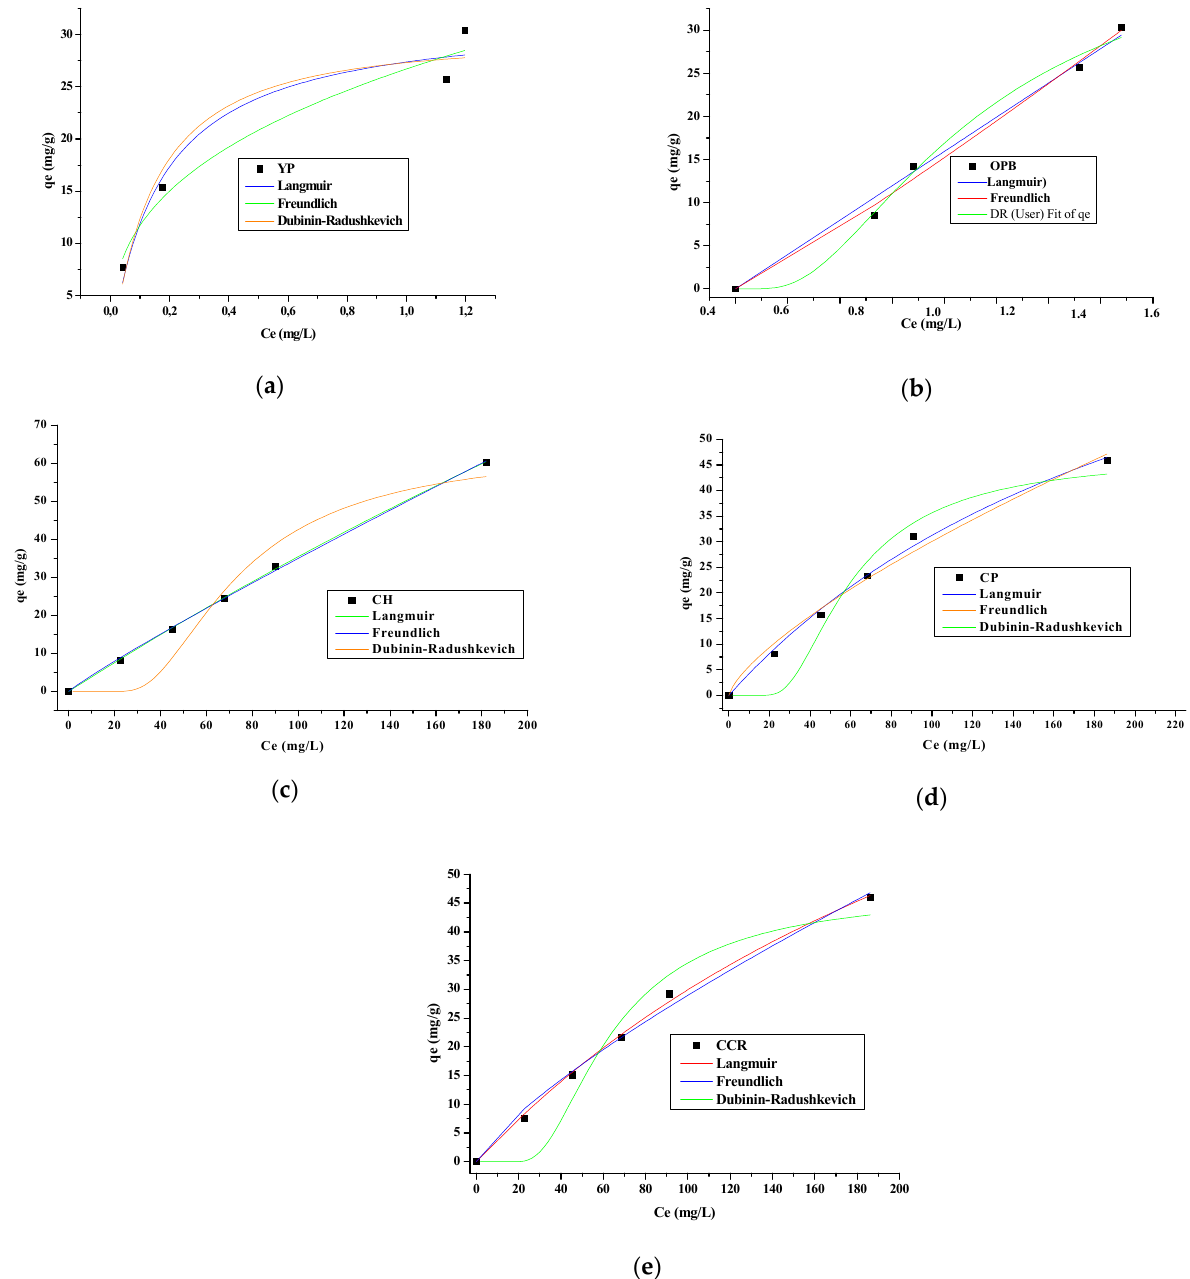
Figure 7. Fitting the Langmuir, Freundlich and Dubinin-Radushkevich’s models of Cd 2+ adsorption ions on ( a ) YP, ( b ) OPB, ( c ) CH ( d ) CP and ( e ) CCR.